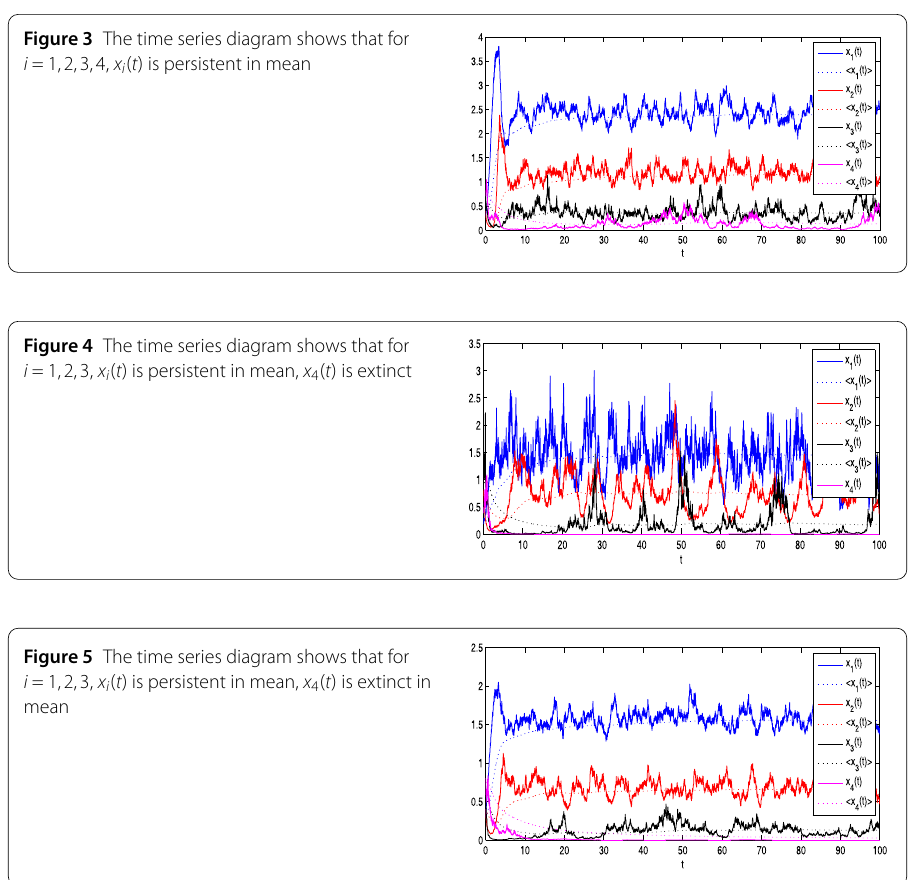
Figure 5 The time series diagram shows that for i = 1,2,3, x i ( t ) is persistent in mean, x 4 ( t ) is extinct